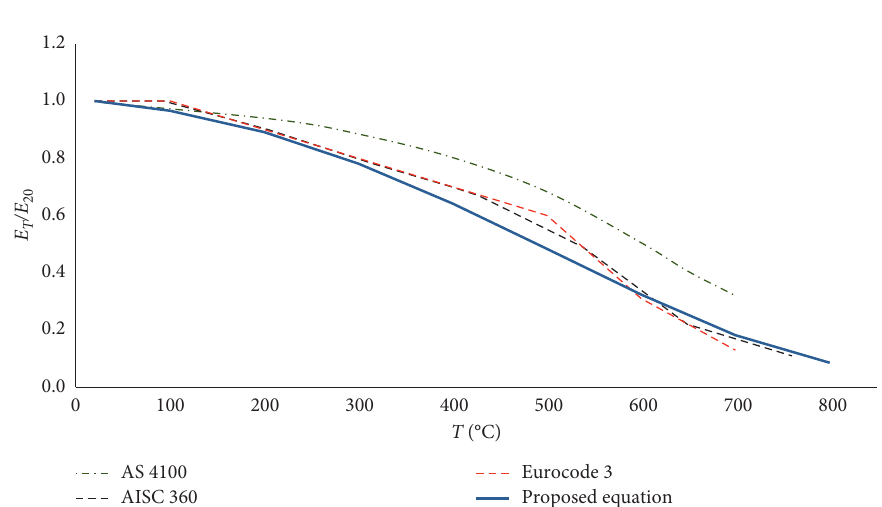
Figure 20: Fitting curve of the retention factors for elastic modulus.